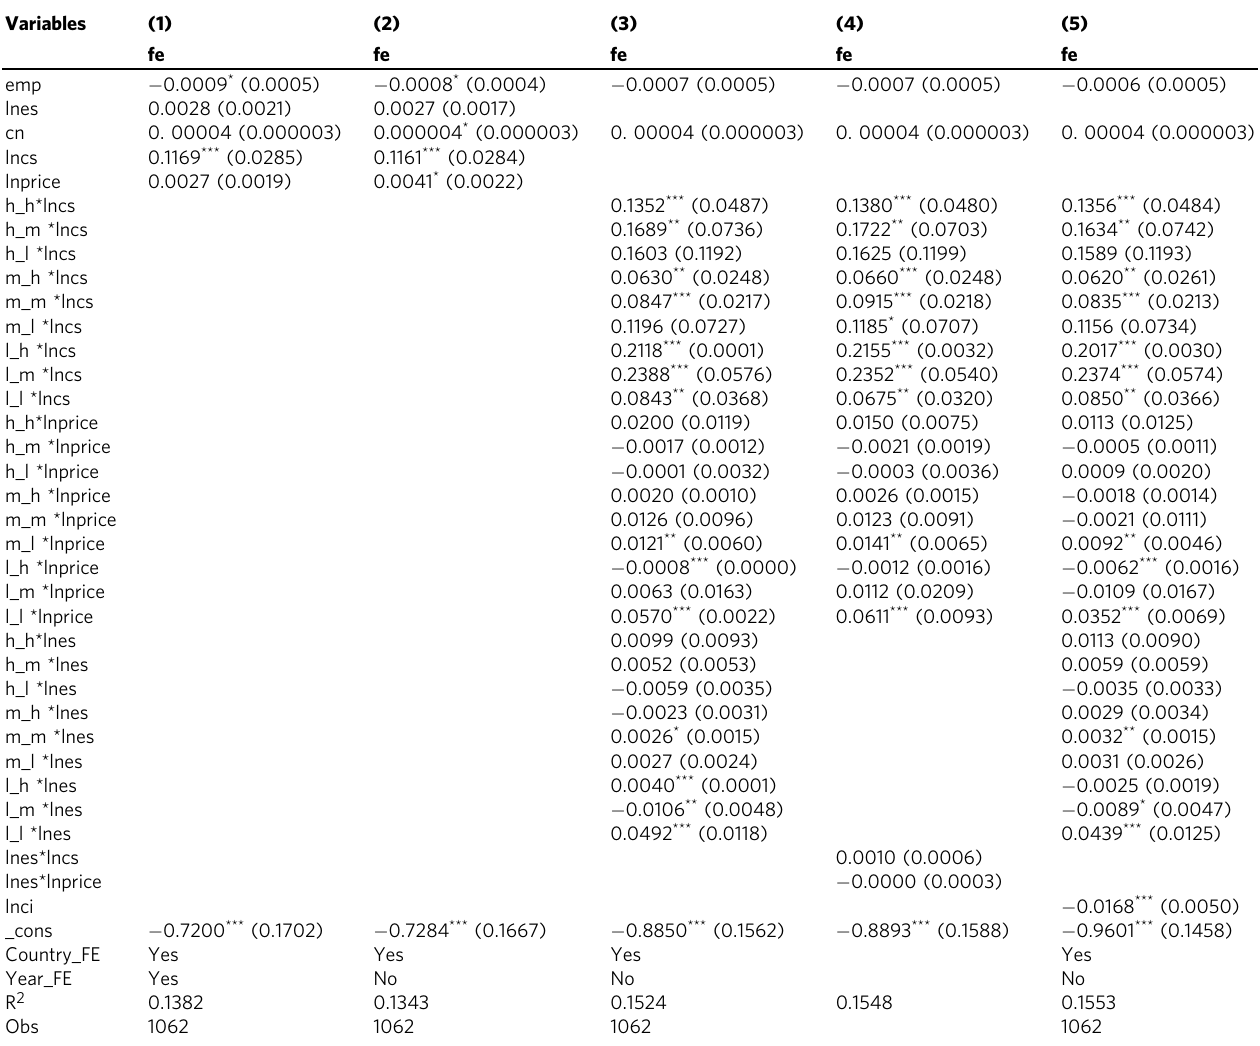
Table 1 Effect of net primary production and carbon shadow price on reo.